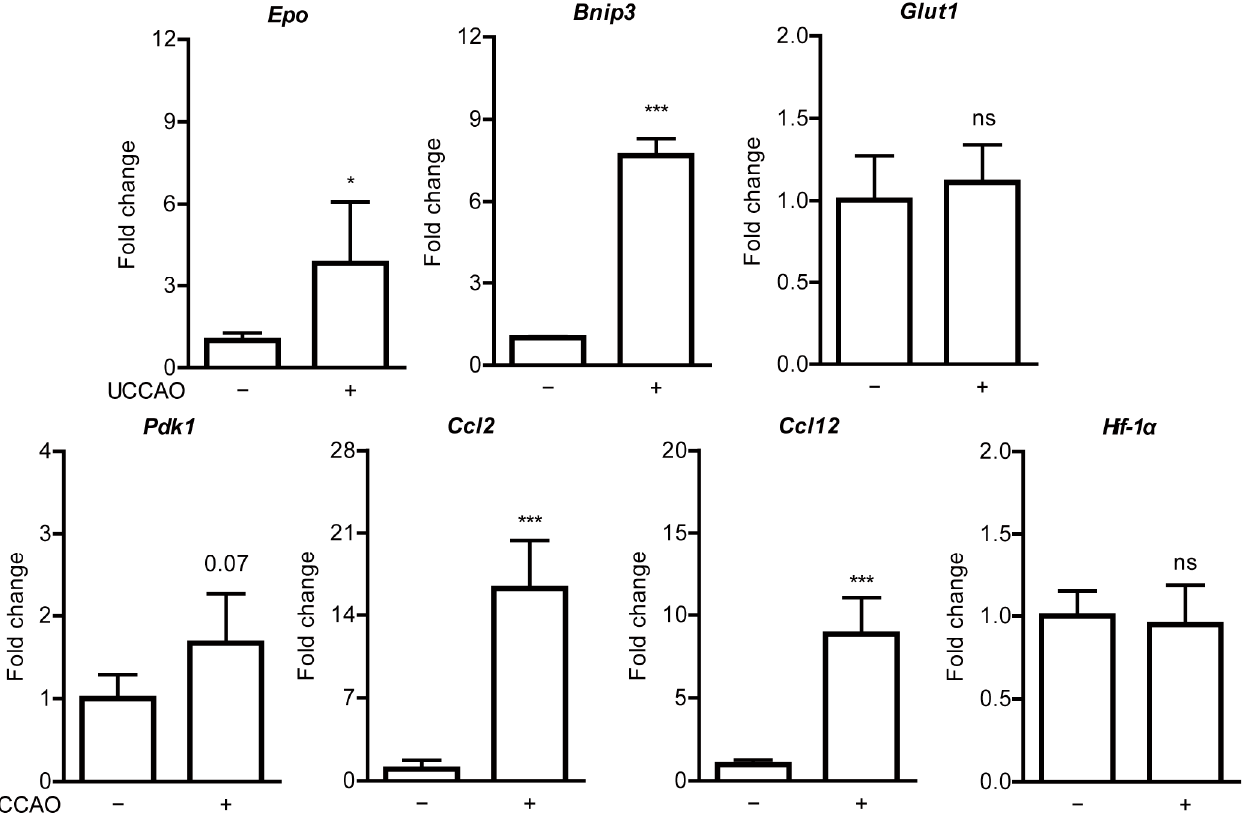
Figure A1. Increases in hypoxia-responsive gene expressions in the retina after UCCAO. Quantitative analyses ( n = 4–7 per group) show increases in expressions of Epo , Bnip3 , Ccl2, and Ccl12 in the UCCAO-operated retina 2 days after UCCAO, in comparison with those in the sham-operated retina. * p < 0.05, *** p < 0.001. The data were analyzed using Student’s t -test (two-tailed) and presented as mean ± standard deviation. UCCAO; unilateral common carotid artery occlusion.